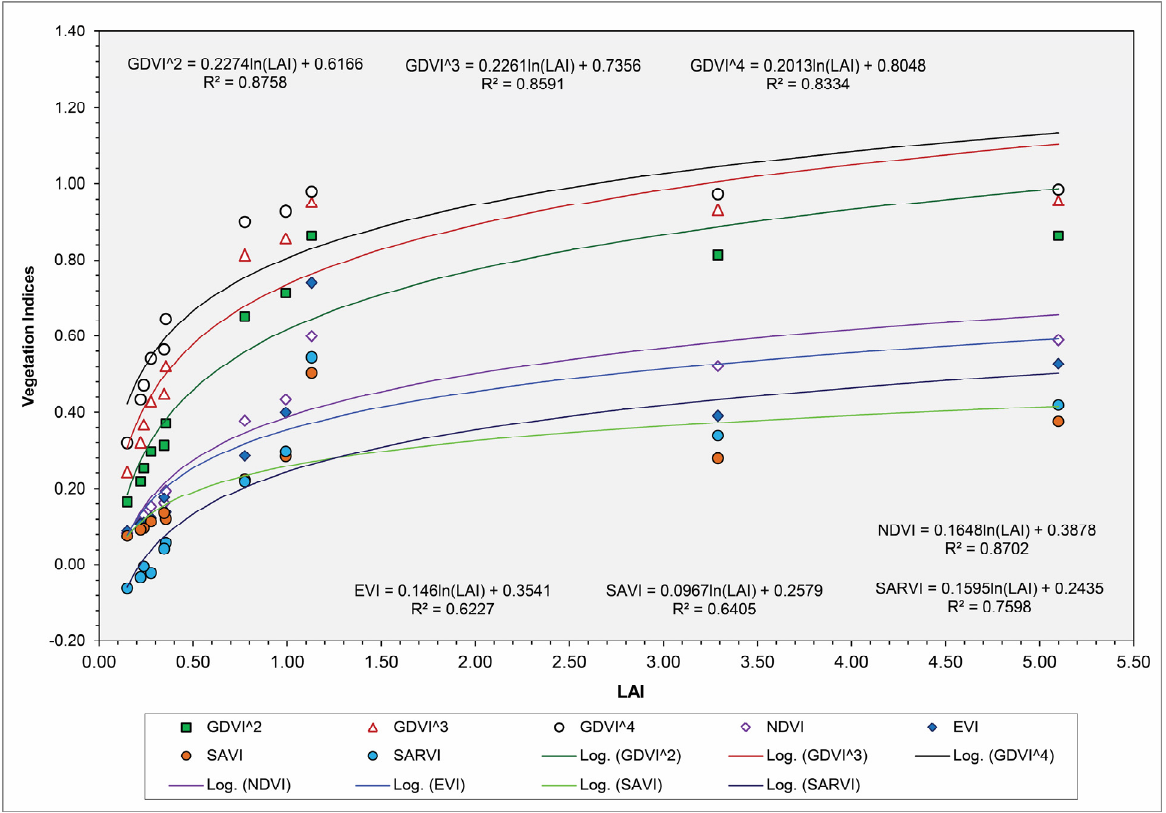
Figure 4. Logarithmic relationships between vegetation indices and LAI (image pair dated 12 July 2010).